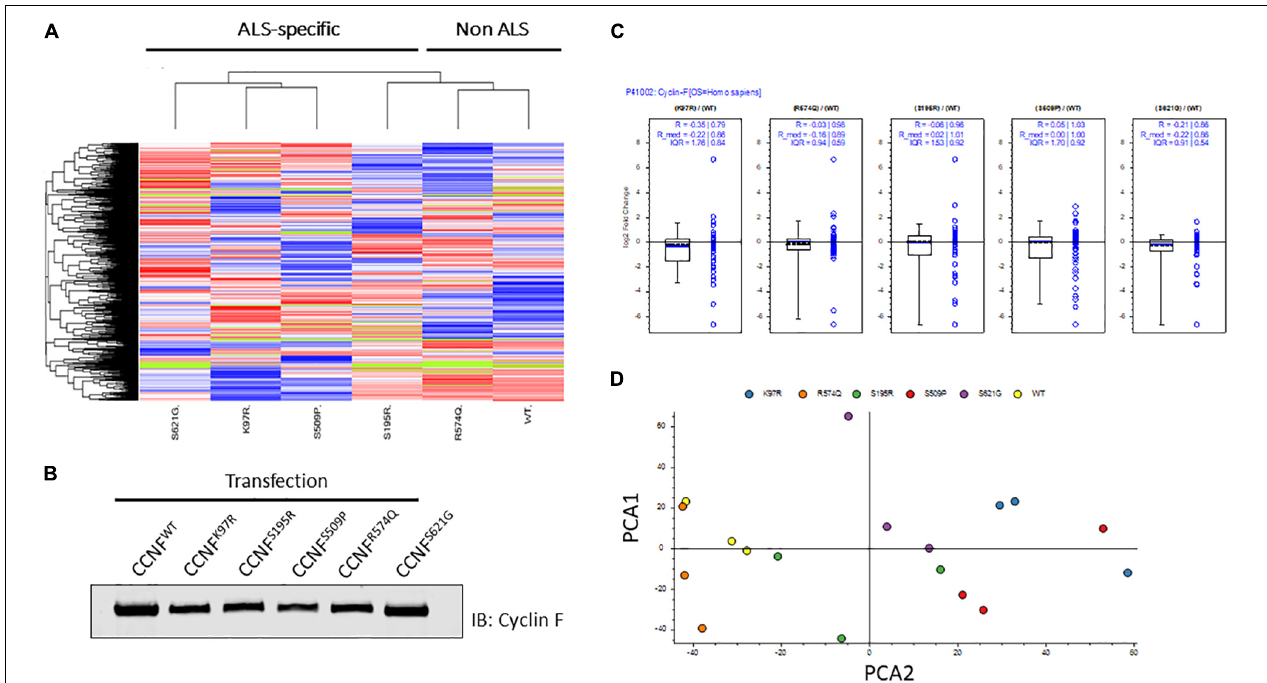
FIGURE 2 | Label-free quantitative proteomics of HEK293 cells transfected with different cyclin F mutations (wild type, K97R, S195R, S509P, R574Q, S621G). (A) Hierarchical group clustering of proteome profiles from transfected cells showed ALS-specific and non-ALS mutations grouped together. Immunoblot analysis (B) and LFQ proteomics (C) of relatively equal cyclin F expression levels in transiently transfected HEK293 cells. (D) Two-dimensional principle component analysis (PCA) reflects the data quality and similarities of the proteome profiles between each biological replicate that are grouped by cyclin F mutations. Figures (A,C,D) were generated using Proteome Discoverer 2.3